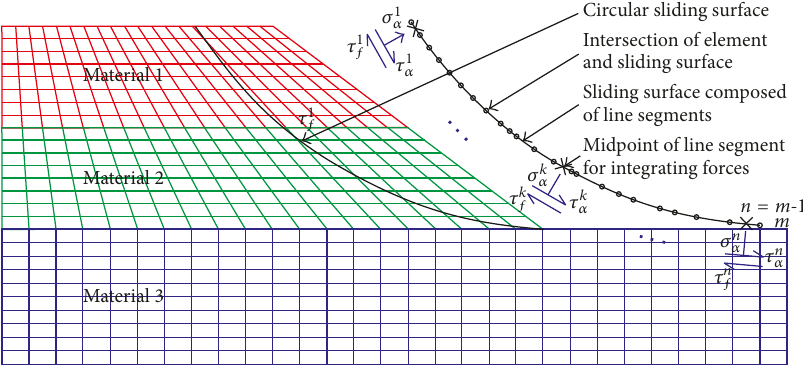
Figure 10: The sliding surface composed by small line